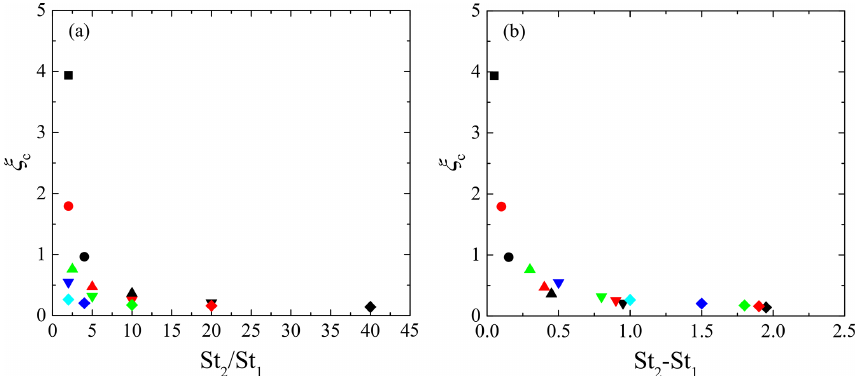
Figure 5. (a) Critical wave number ξ c against the Stokes number ratio St 2 /St 1 , and (b) against the Stokes number difference, St 2 – St 1 . Notations are as in Fig. 4.